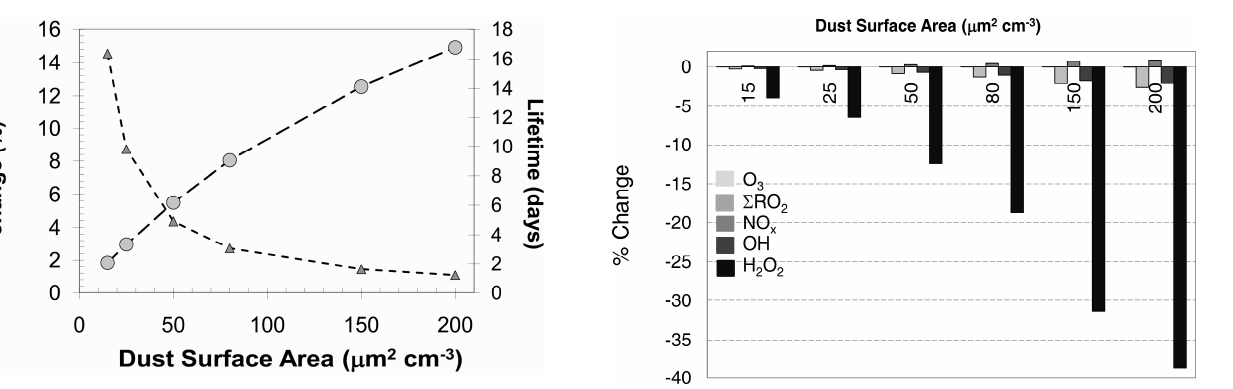
Fig. 7. The effects of including reactive uptake of H 2 O 2 as a func- Figure 7. The effects of including reactive uptake of H 2 O 2 as a function of dust loading for a 3 tion of dust loading for a range of trace range of trace gases. 4